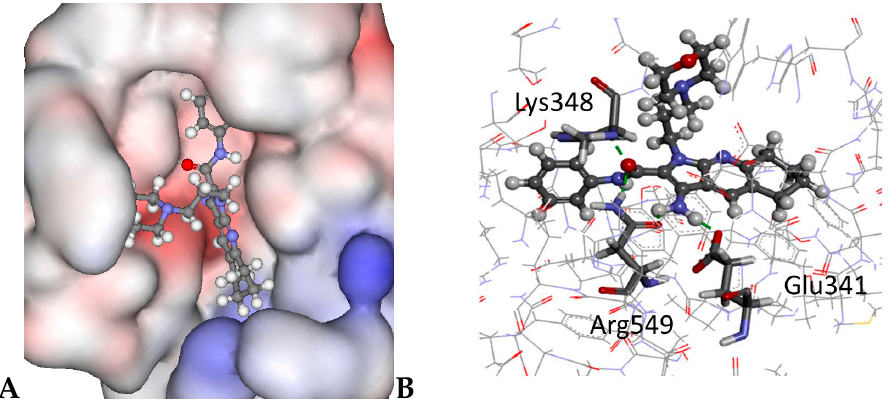
Figure 3. The docked configuration of 3 : ( A ) to the binding site of PLC- δ 1 using the ChemPLP scoring function. The morpholine occupies a cleft on the protein surface, but has access to the water environment. The protein surface is rendered. Red depicts a positive partial charge on the surface, blue depicts negative partial charge and grey shows neutral/lipophilic areas; ( B ) Hydrogen bonds are depicted as green lines between the ligand and the amino acid residues Lys348, Arg549, and Glu341.